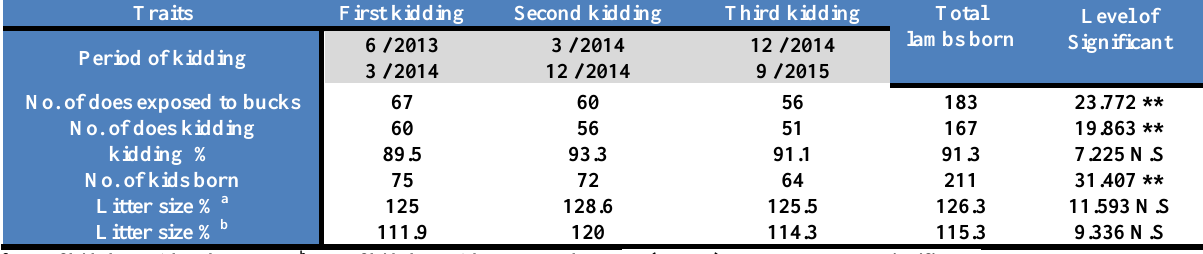
Table, 1: Comparisons between the first kidding and the total lambs born for the traits studied. Traits First kidding Second